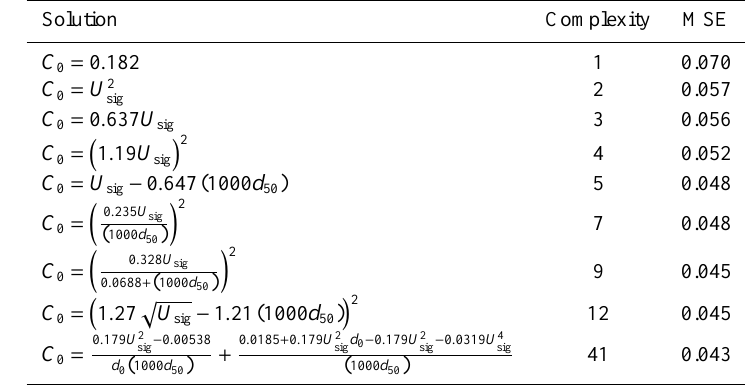
Table 2. Solutions for reference